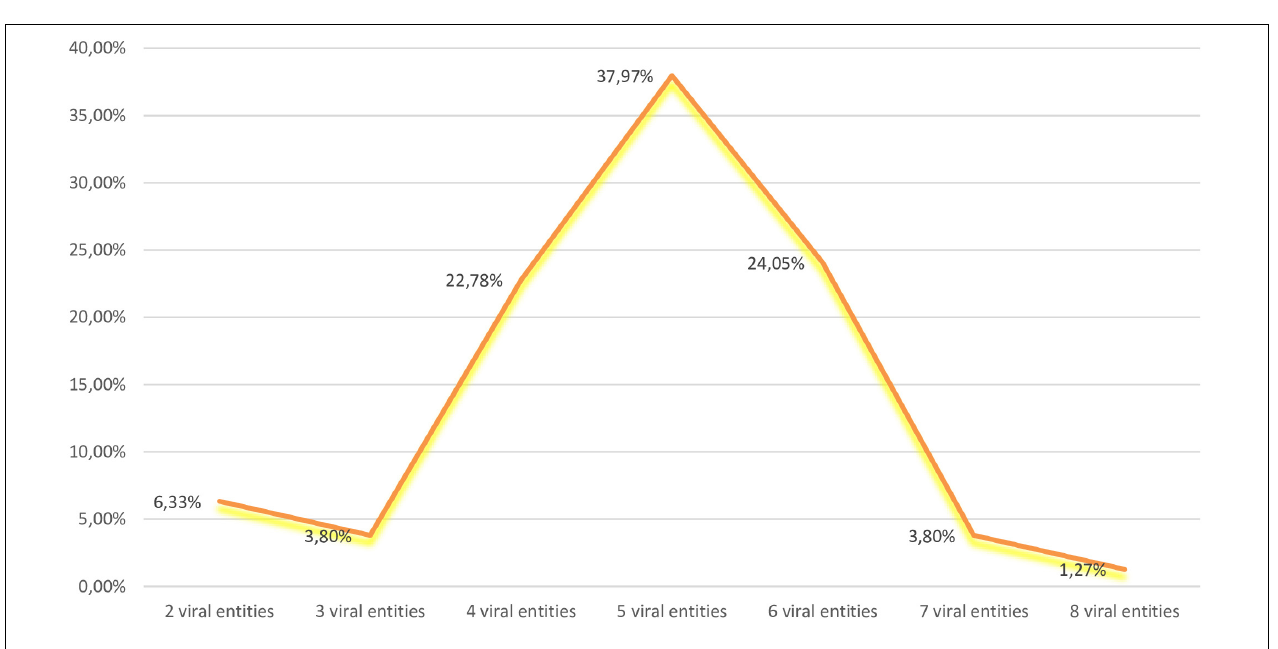
FIGURE 2 | Percentages of co-infections in analyzed samples.